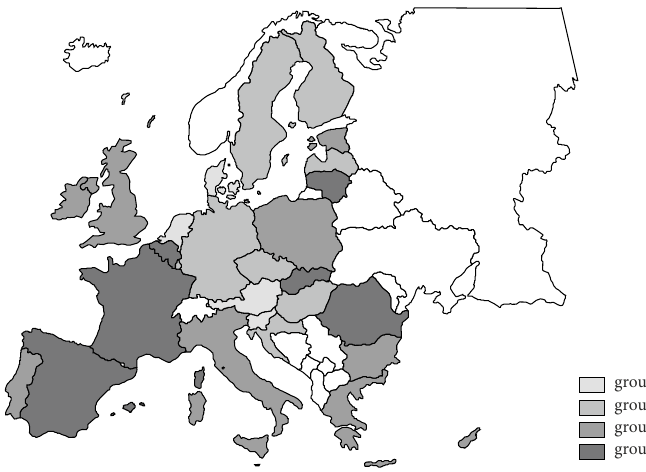
Figure 4. Spatial distribution of EU countries according to the level of sustainable development in